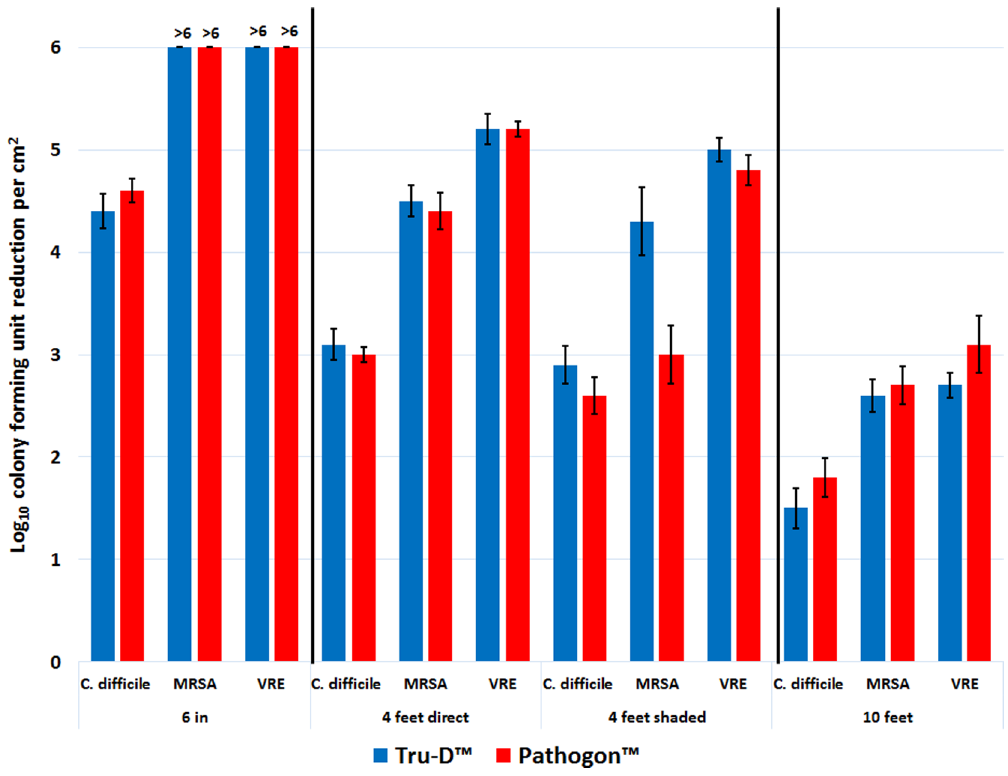
Figure 4. The effect of distance and indirect irradiation on the efficacy of the UV-C devices. The log 10 CFU reduction/cm 2 of C.difficile spores, MRSA, and VRE at increasing distances and shaded from the direct field of radiation delivered by the UV-C device. Carriers contained 6 log 10 CFU of each pathogen. The carriers were irradiated for 41 minutes at a distance of 6 in, 4 feet, 4 feet shaded, and 10 ft from the Tru-D or Pathogon device. The means of the data from experiments conducted in triplicate are presented. Error bars indicate standard